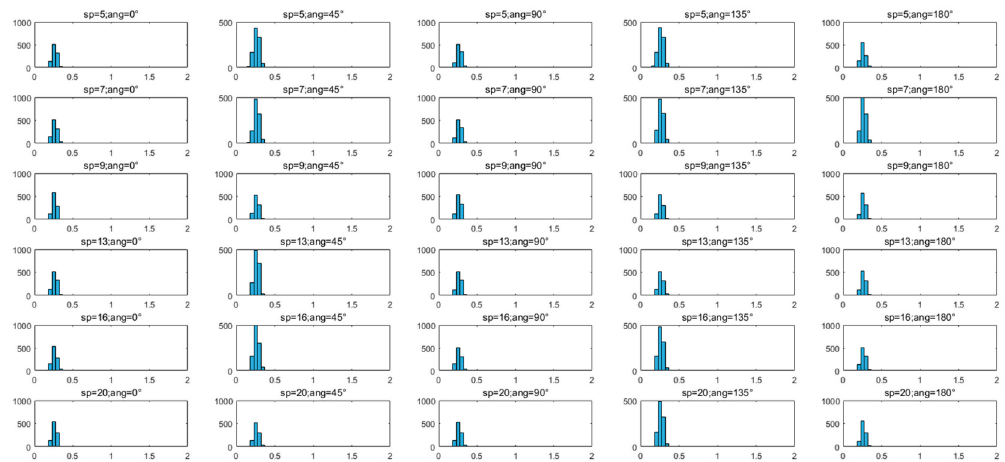
Figure 9. Histogram of refraction angle frequency distribution of 1000 pulse spots.